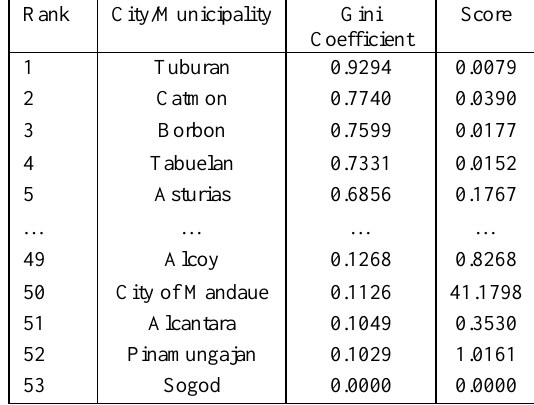
Table 2: Top 5 and Bottom 5 Cebu Cities/Municipalities based on Gini Coefficient